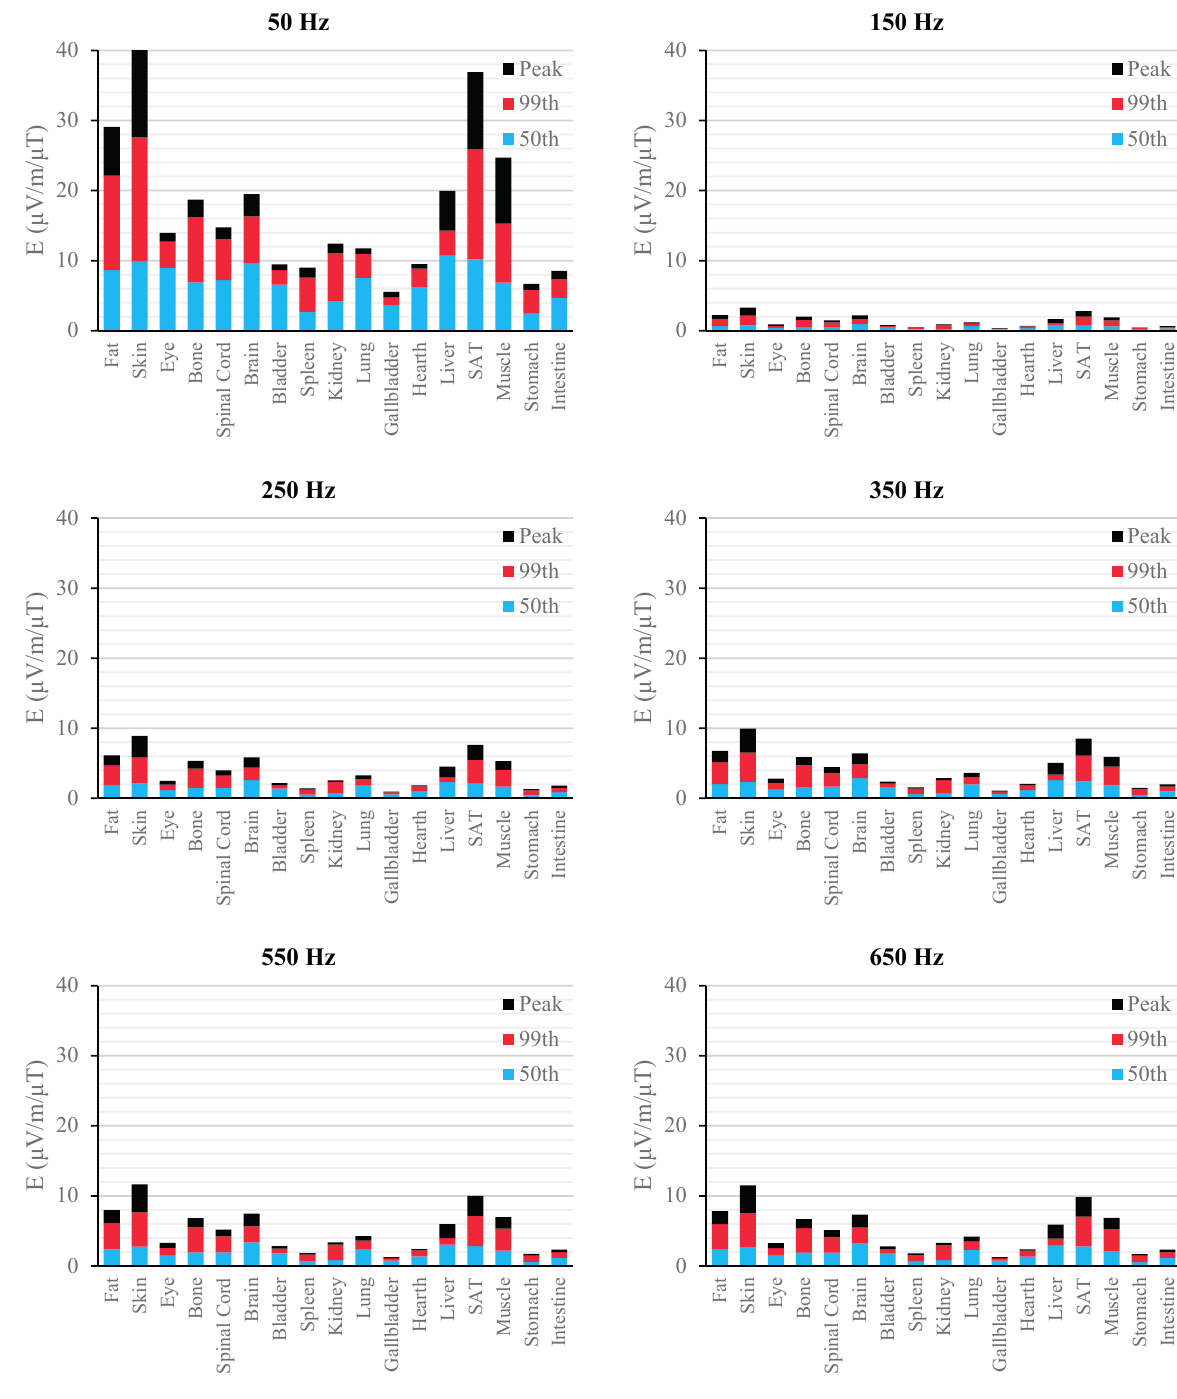
Figure 5. E ( μ V/m) per μ T of 50 Hz B peak induced in foetal tissues at 7 mGA for all the harmonic frequencies considering the standard EN 50160 for the HV power supply networks. The bars indicate the E 50th (blue), the E 99th (red) percentiles and the E peak (black) of each